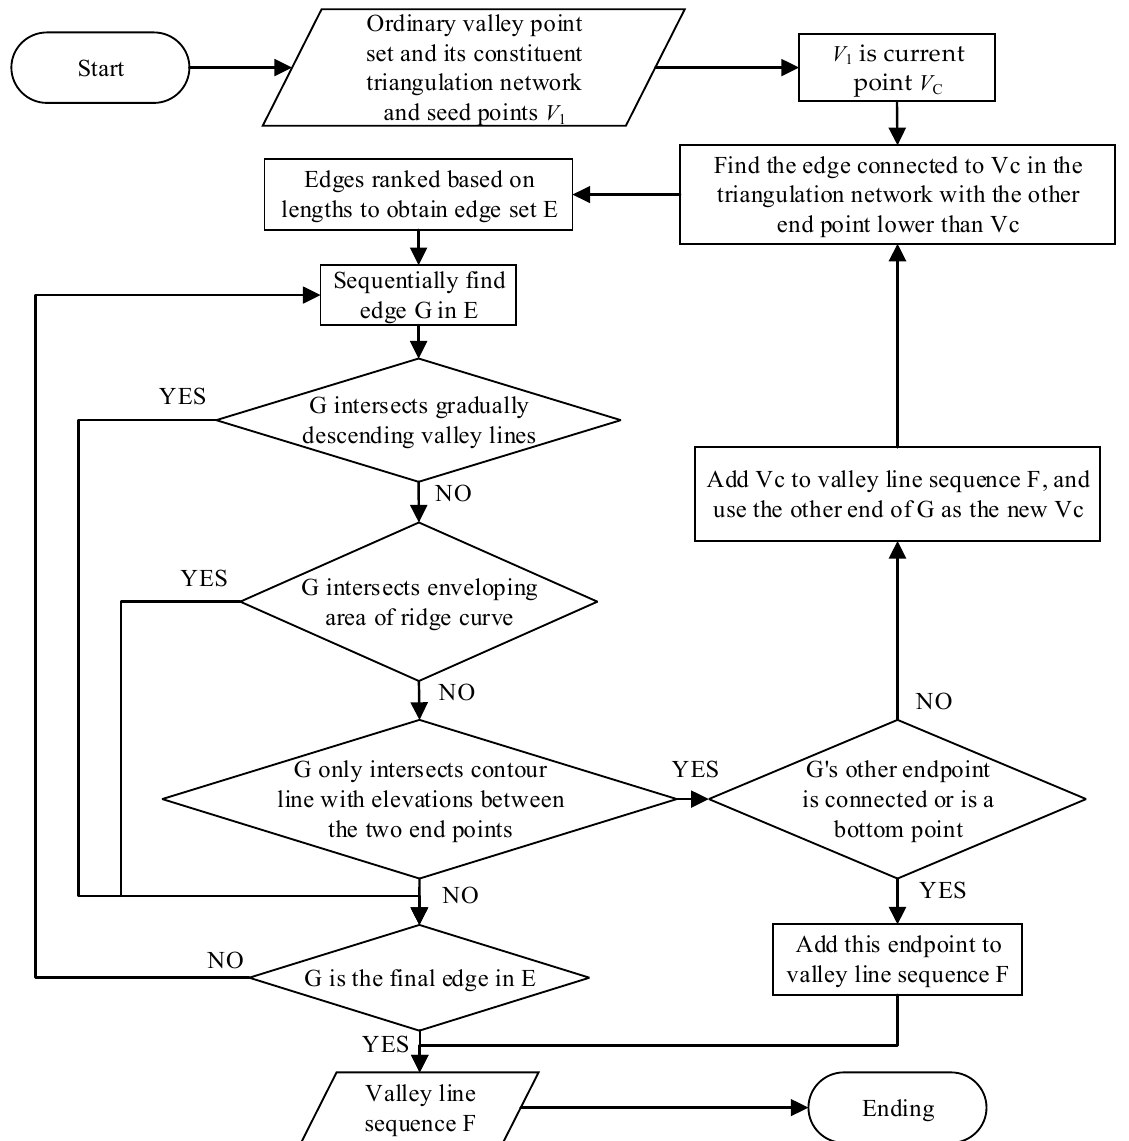
Figure 7. Ordinary valley line connection process.